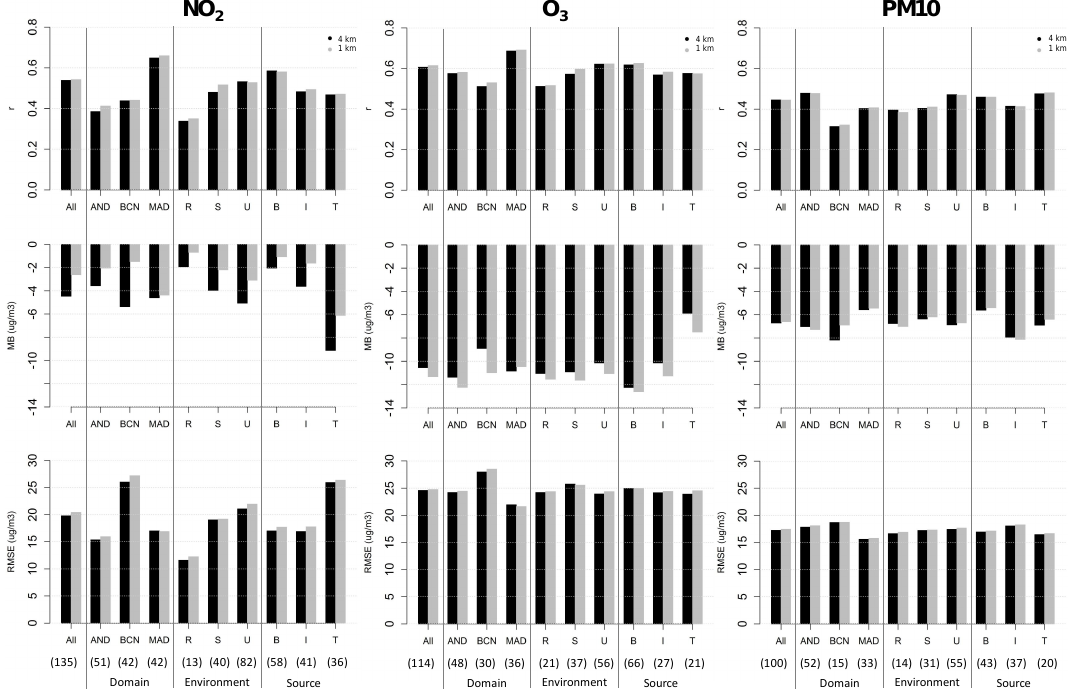
Figure 7. Statistics ( r , MB, and rmse in the rows) for each pollutant (NO 2 , O 3 , and PM 10 in the columns) on an hourly basis as a function of horizontal resolution: 4km (black) and 1km (grey). Four categories are considered: all stations (all), domain (AND, BCN and MAD), station environment ( R , S , and U ), and main sources ( B , I , and T